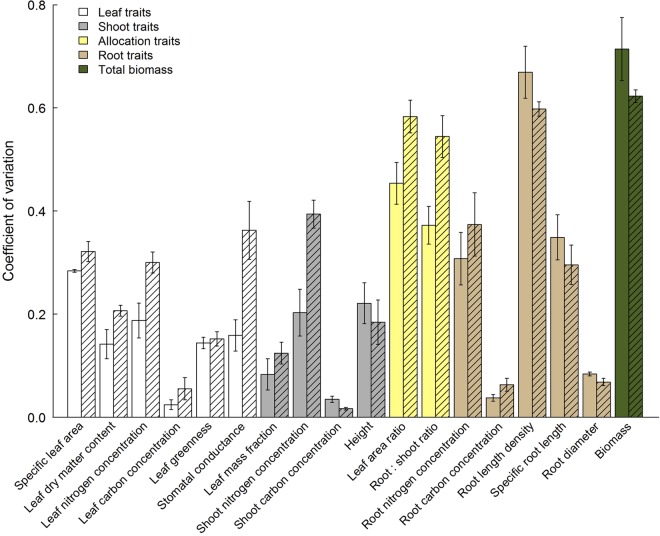
Intraspecific trait variation in response to resource availability estimated as coefficient of variation (CV, standard deviation over means) across treatments. Shown are means (±1 SE) across species. Hatched bars represent grass species.